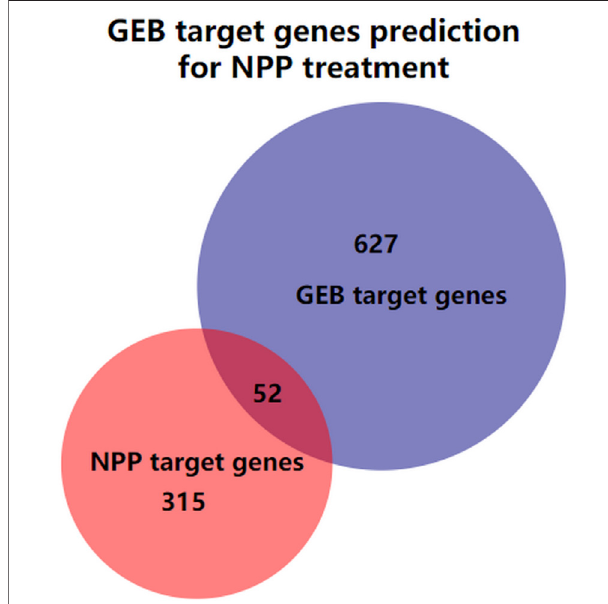
FIGURE 2 | The Venn diagram illustrating the intersection of the GEB target genes and NPP target genes. The blue circle is the GEB target genes, the red circle is the NPP target genes, and the overlap of the two circles indicates GEB target genes prediction for NPP treatment.